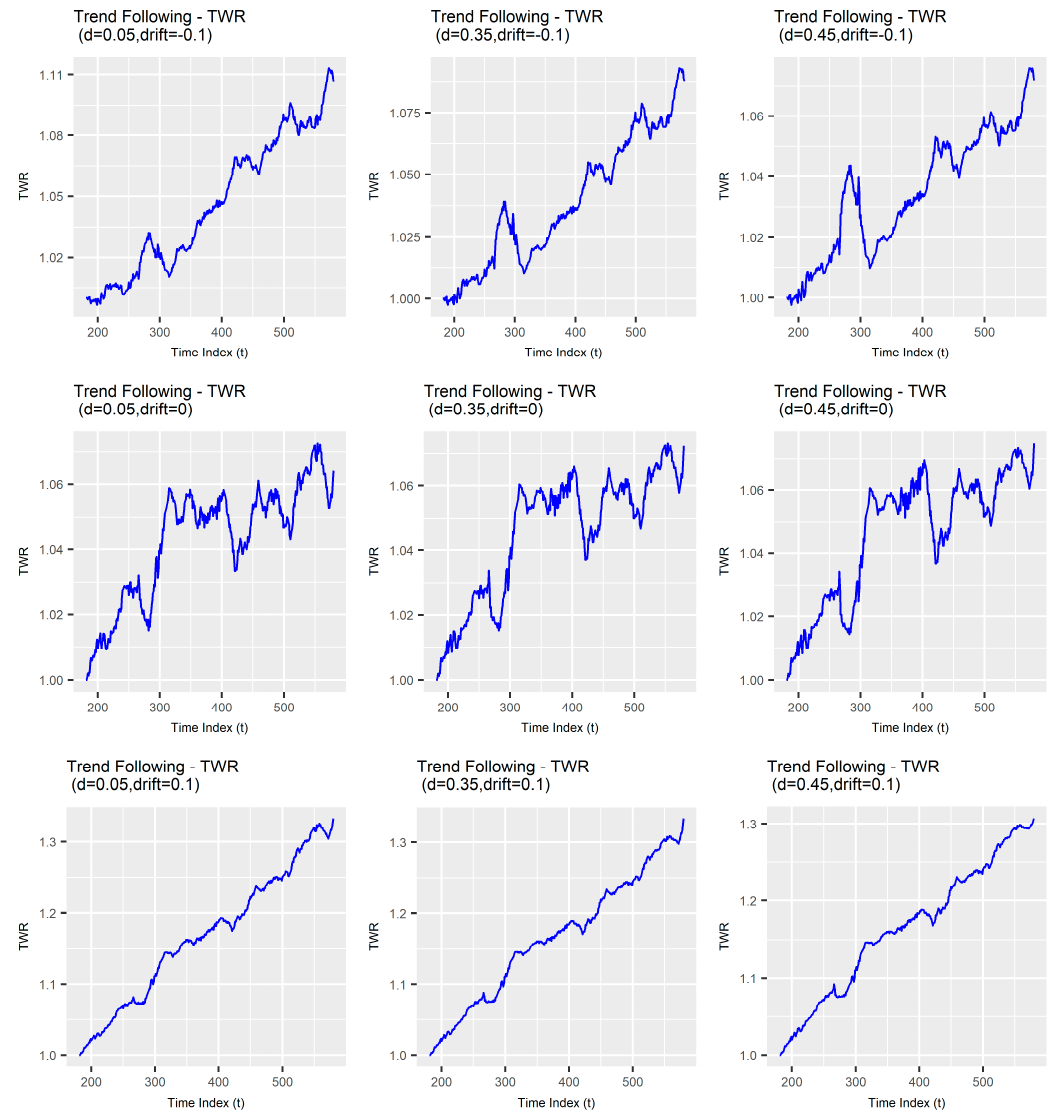
Figure 10. Terminal wealth relative (TWR) curves .